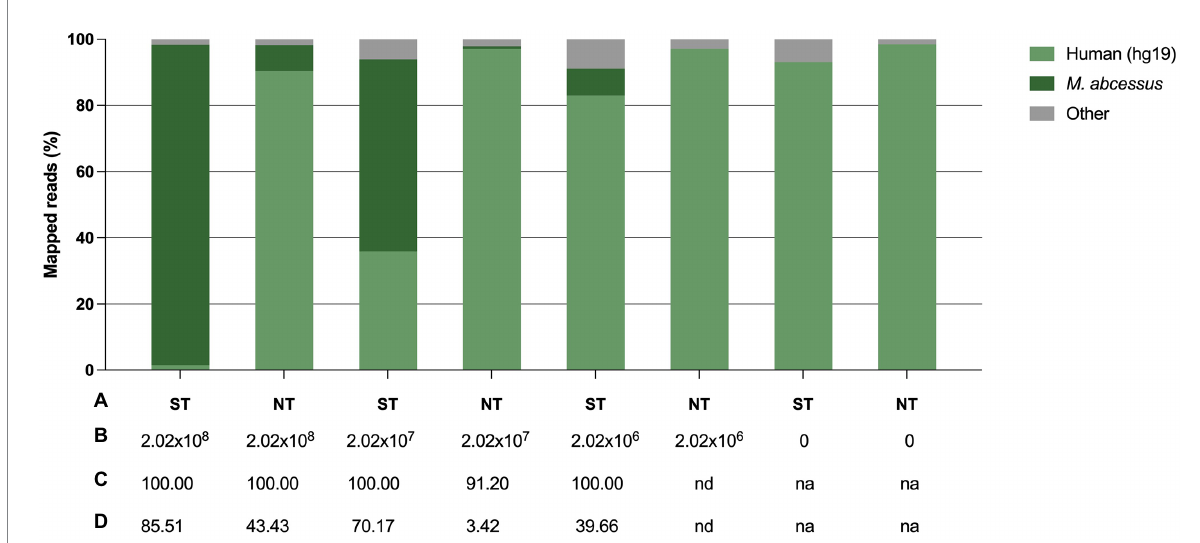
FIGURE 5 Effect of saponin treatment (depleting host DNA) on sputum spiked with M. abscessus at three different concentrations. (A) Condition, i.e., saponin treated (ST) or non-treated (NT), (B) Final concentration of spiked M. abscessus (CFU/ml), (C) M. abscessus genome coverage (%), (D) M. abscessus mean sequencing depth (average number of reads per sites). 0 concentration refers to non-spiked sputum samples. na, not applicable; nd, not